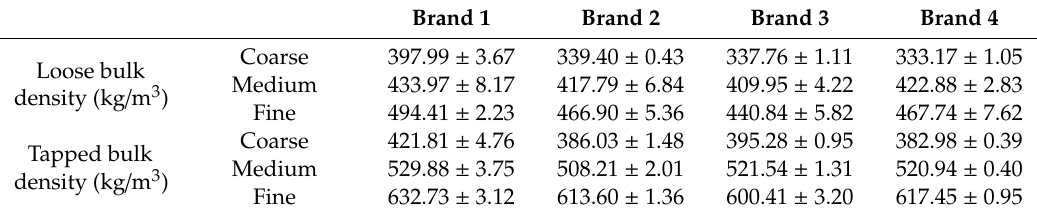
Table 1. Tapped and loose bulk density of coarse, medium, and fine particles for four brands of milk powders.